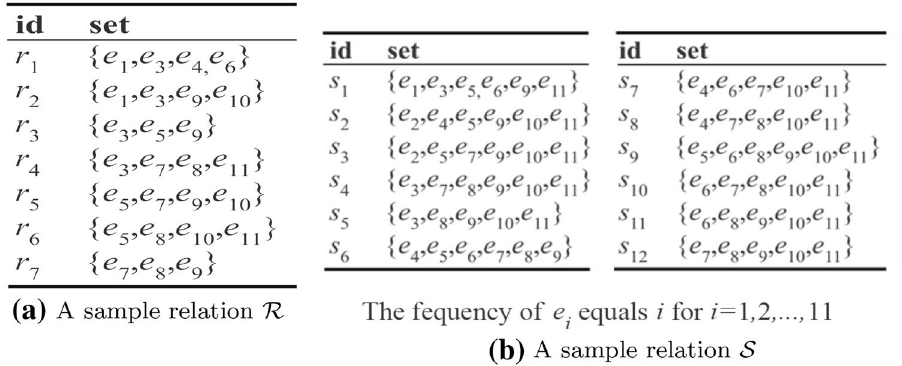
Fig. 1 Two relations for running